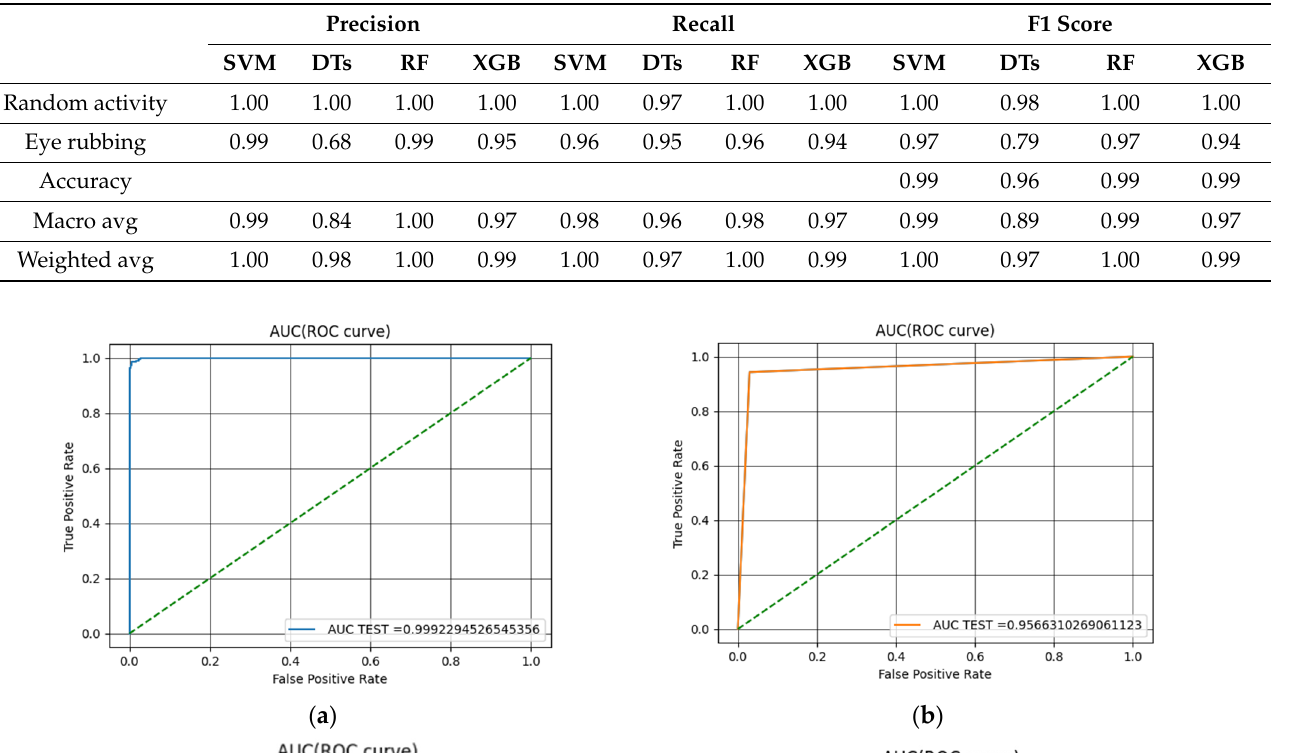
Table 3. The precision, recall, and F1 score metrics.